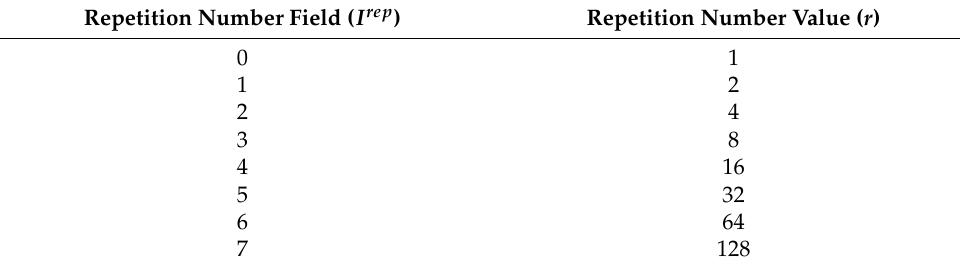
Table 6. The supported uplink number of repetitions in NB-IoT.